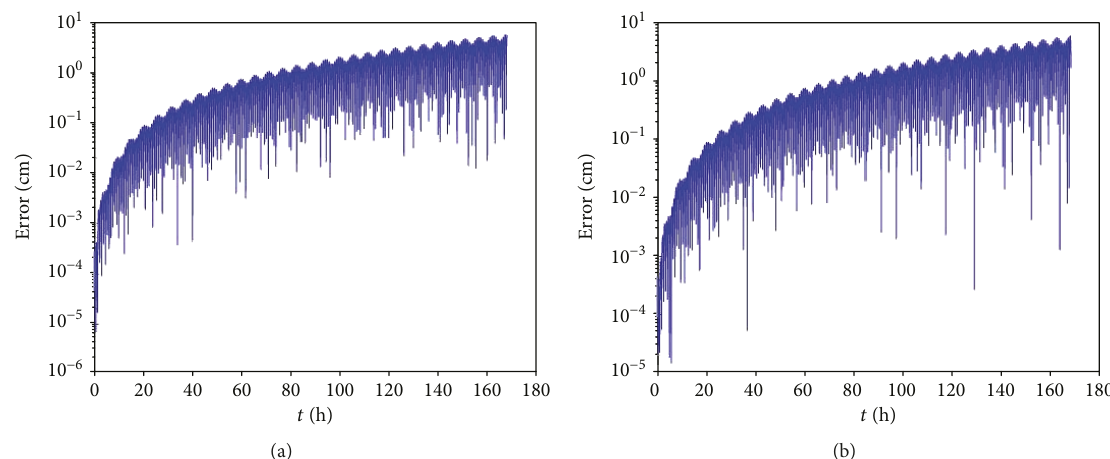
Figure 3: Di ff erence between the ode45 MATLAB and the SODE solutions for the Newtonian (a) X coordinate and (b) Y coordinate, with TOL =10 − 13 and TOL =10 − 13 . The scale is semilogarithmic. r a